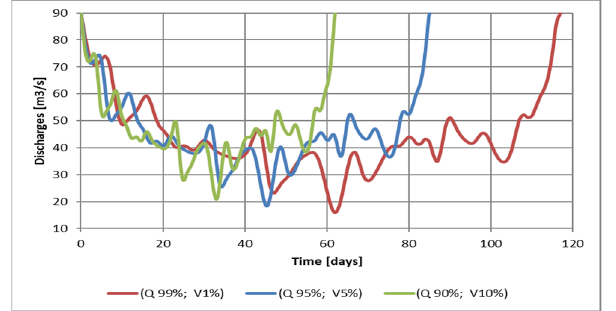
Figure 12. Synthetic drought hydrographs Class 3: (cid:4666)𝑄 (cid:2877)(cid:2877)% (cid:3040)(cid:3036)(cid:3041) ; 𝑉 (cid:2869)% (cid:4667) ; (cid:4666)𝑄 (cid:2877)(cid:2873)% (cid:3040)(cid:3036)(cid:3041) ; 𝑉 (cid:2873)% (cid:4667) ; (cid:4666)𝑄 (cid:2877)(cid:2868)% (cid:3040)(cid:3036)(cid:3041) ; 𝑉 (cid:2869)(cid:2868)% (cid:4667) .